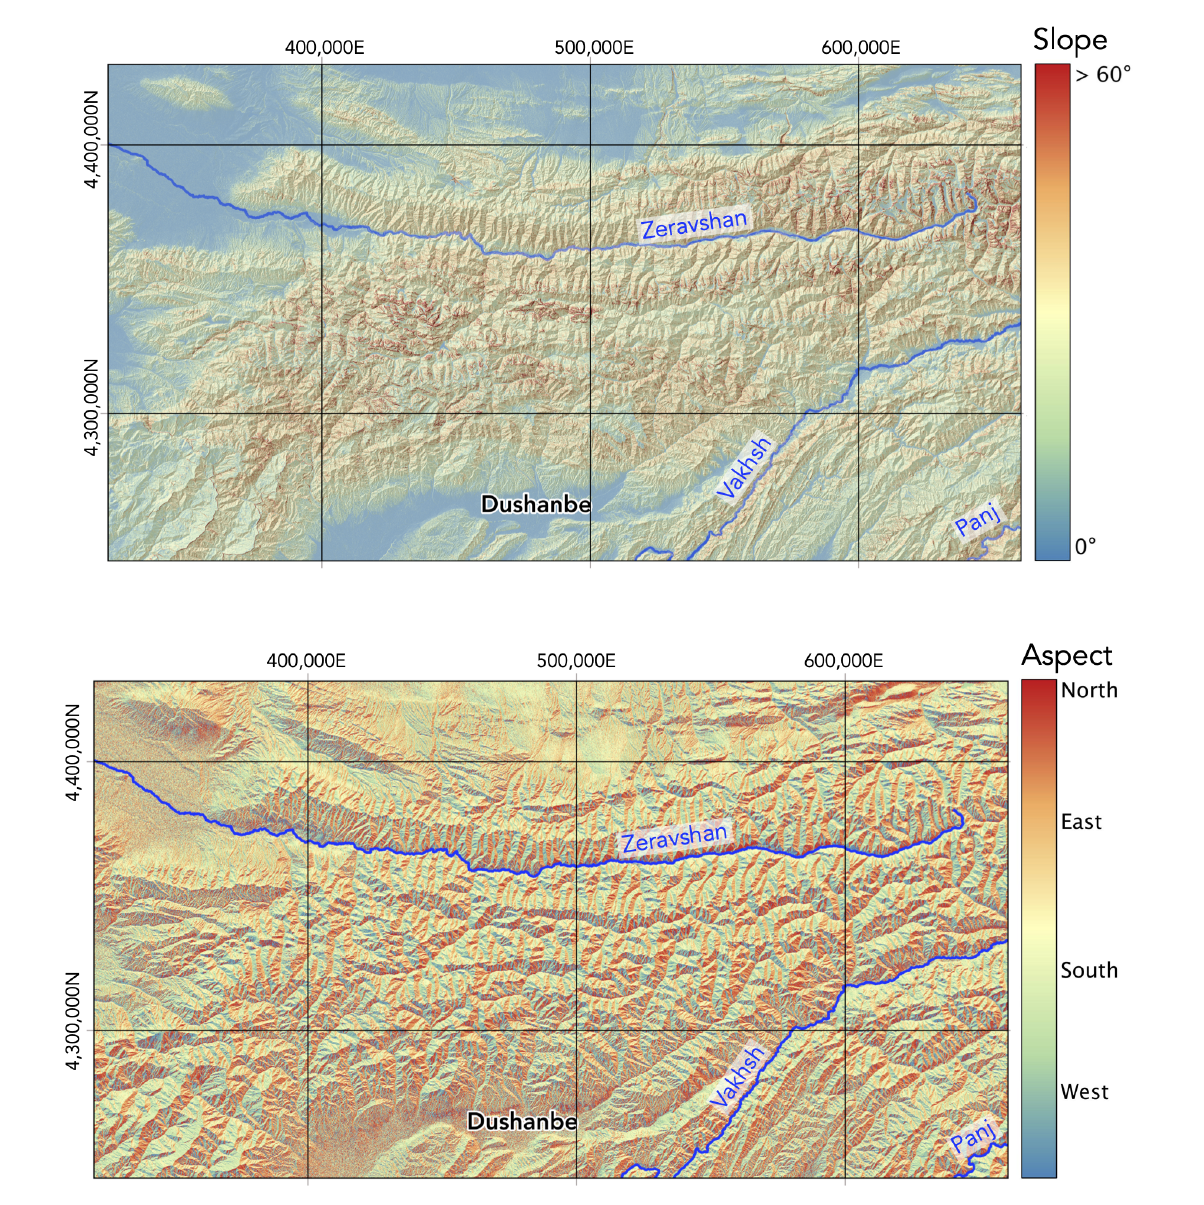
Figure A5. Simple morphometric